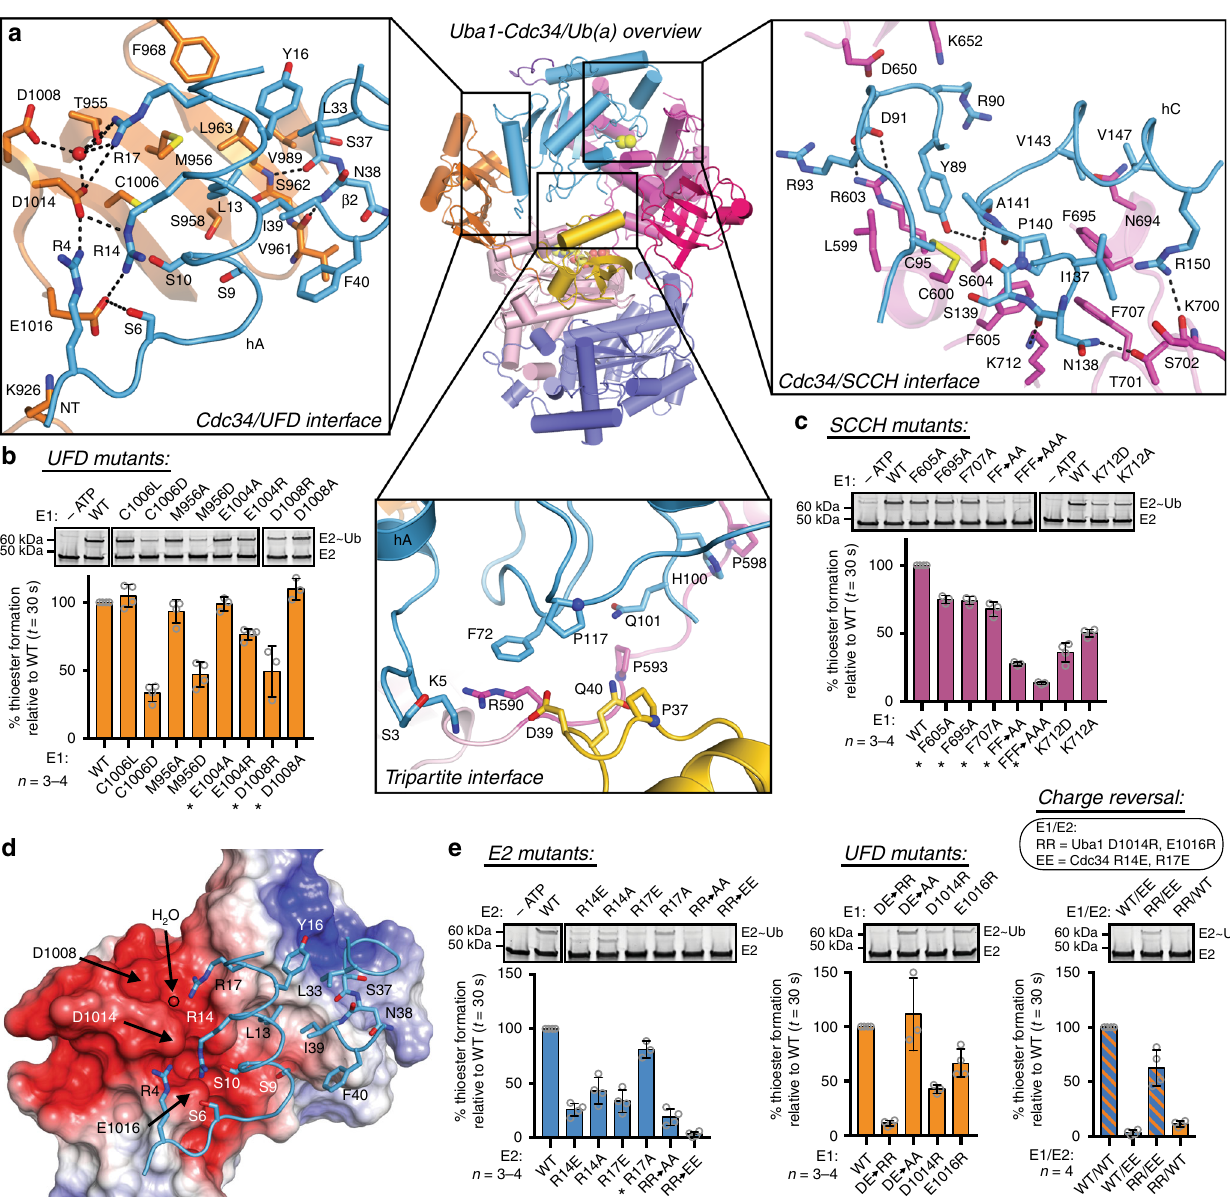
Fig. 2 Combinatorial recognition of Cdc34 Δ dist by ScUba1. a Top middle , overall structure of Uba1-Cdc34 Δ dist /Ub as in Fig. 1a. Top left , network of contacts between Uba1 UFD and Cdc34 with involved residues shown as sticks with red oxygen atoms, blue nitrogen atoms, and yellow sulfur atoms. Hydrogen bonds are indicated by dashed lines. Top right , interaction network between Cdc34 and Uba1 SCCH. Bottom middle , tripartite network between Cdc34, Ub (a), and Uba1 crossover loop. b , c E1-E2 thioester transfer assays of the indicated mutants for Uba1 UFD ( b ) and SCCH ( c ). Data are represented by mean ± SD with representative replicates labeled above and individual replicates shown as gray circles. Biochemical assays have four independent replicates, unless indicated by an asterisk when there are three replicates. d Electrostatic surface of Uba1 UFD with Cdc34 contacting residues overlaid as in a . e E1-E2 thioester transfer assays of the indicated mutants for Cdc34 (E2), Uba1 UFD, and a charge reversal rescue assay with mutant Uba1 and Cdc34,